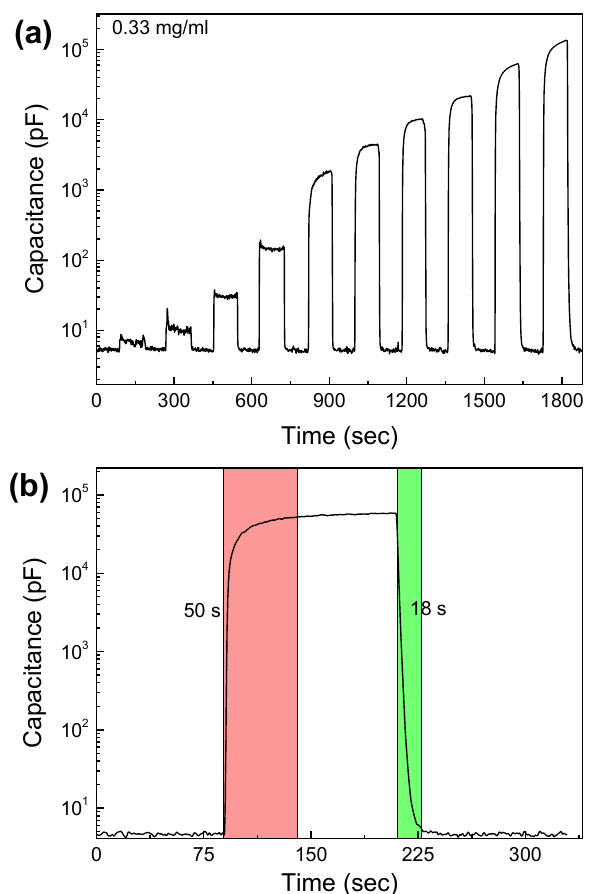
Figure 5. Performance characteristics of the LIG/GO interdigitated electrode humidity sensor. ( a ) Dynamic response vs. relative humidity from 0–97% and ( b ) response and recovery of the sensor vs. 80% RH.